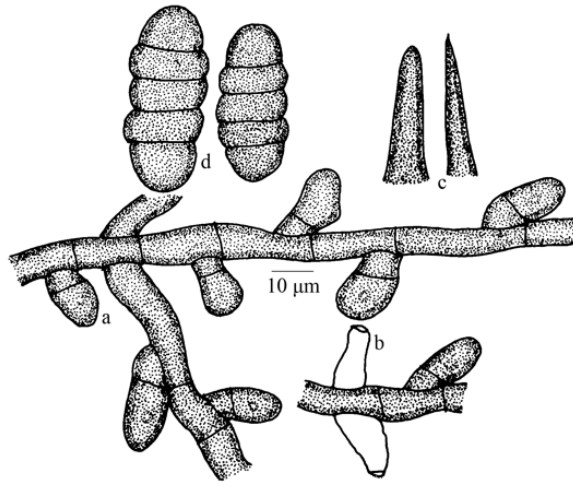
Figure 97. Meliola mayapeae a - Appressorium; b - Phialide; c - Apical portion of mycelial setae; d -